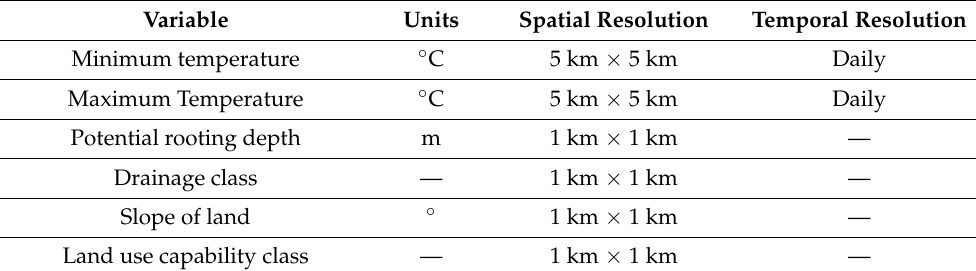
Table 1. Data used in the